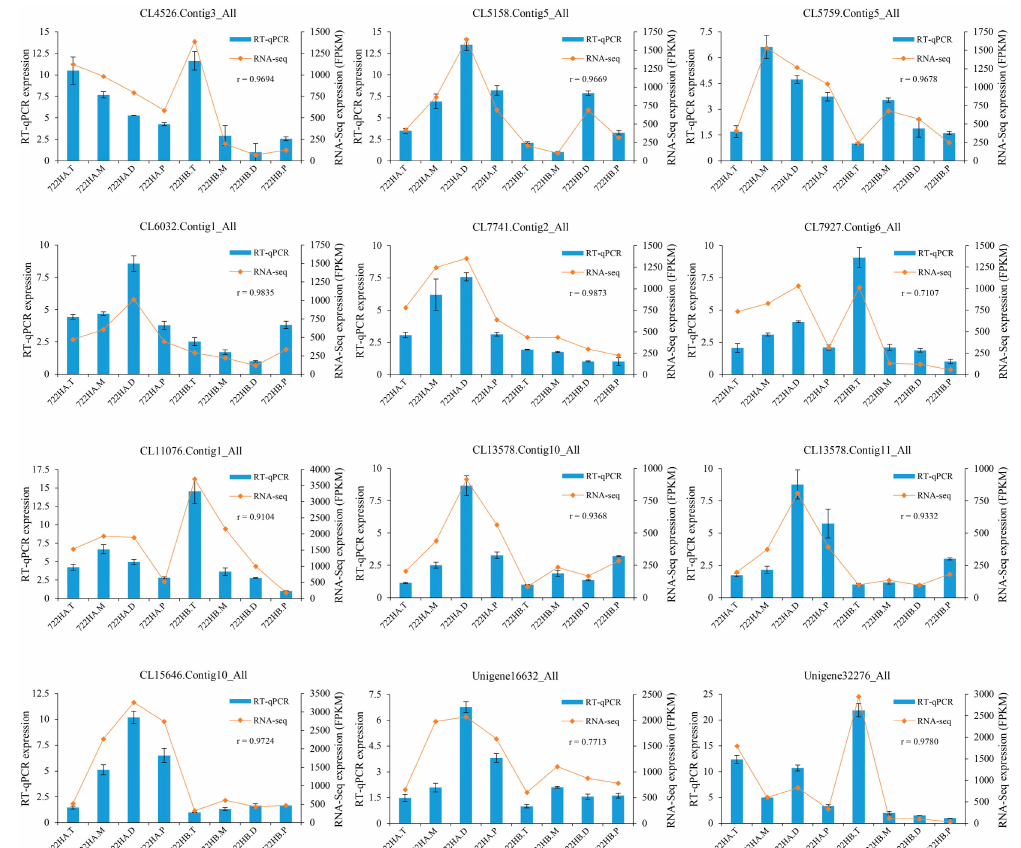
Figure 7. RT-qPCR verification results of 12 genes. The relative expressions levels of the twelve genes were calculated using the 2 − ∆∆ C t method. r: Represents the correlation coe ffi cient between RT-qPCR data and RNA-seq data. 722HA.T, 722HA.M, 722HA.D, and 722HA.P correspond to microspores of the tetrad, mononuclear, dinuclear, and mature pollen grains stages, respectively, in 722HA; 722HB.T, 722HB.M, 722BA.D, and 722HB.P correspond to microspores of the tetrad, mononuclear, dinuclear, and mature pollen grain stages, respectively, in